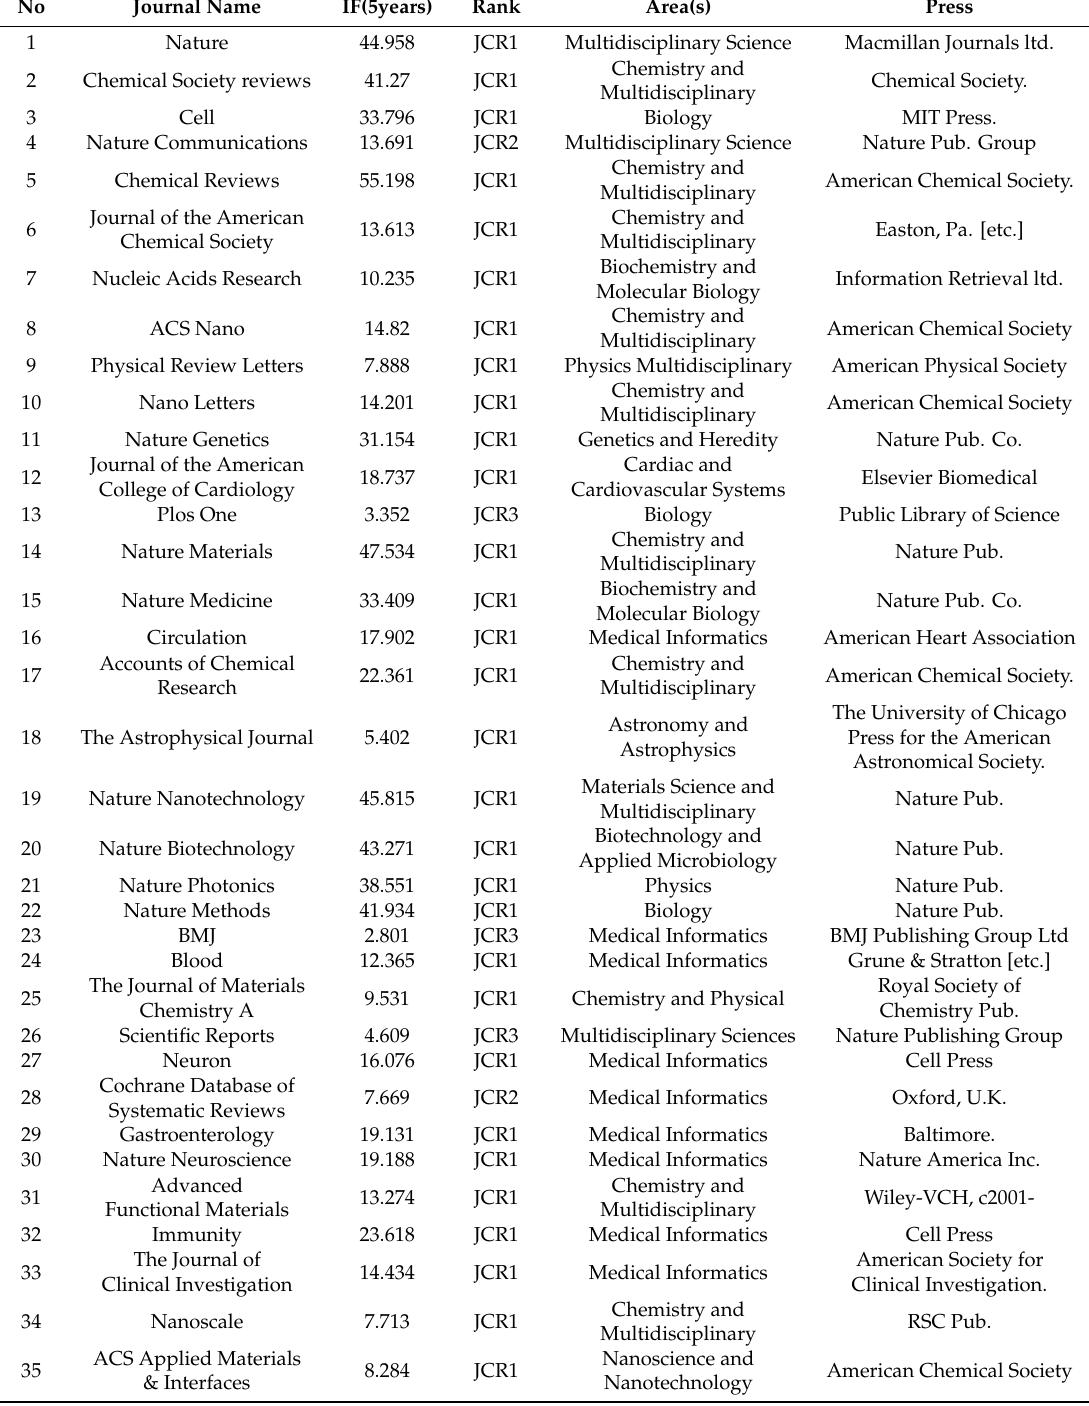
Table 1. Overview of the 77